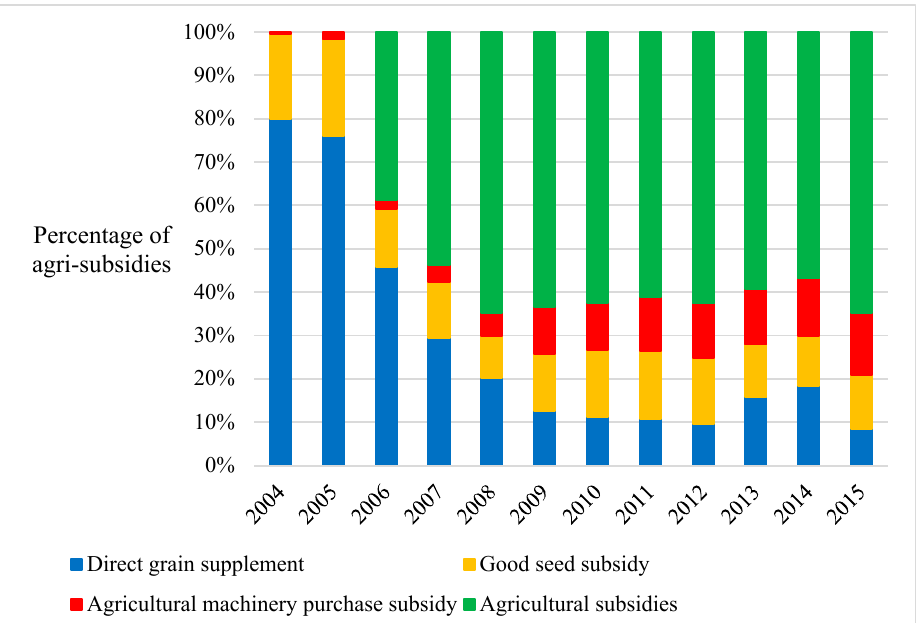
Figure 2. Different types of agricultural subsidies from 2004–2015. Note: Direct grain supplement: a subsidy paid directly to farmers who grow grain to increase their income. Good seed subsidy: a subsidy paid to food farmers to support the use of better crop seeds. Agricultural machinery pur- chase subsidy: a subsidy given to grain-growing farmers for the purchase and upgrade of agricul- tural machinery for grain production. Agricultural subsidies: a direct subsidy given to farmers who grow food to purchase the means of agricultural production, including fertilizer, diesel fuel, seeds, and farm machinery.